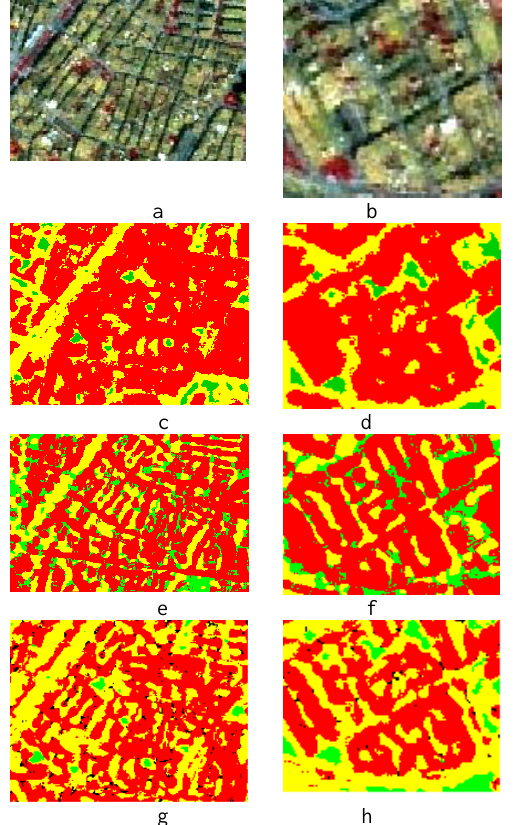
Figure 4. selected sample areas; a,b) SPOT image, c,d) SPOT classification result, e,f) SAR classification result, g,h) decision fusion result